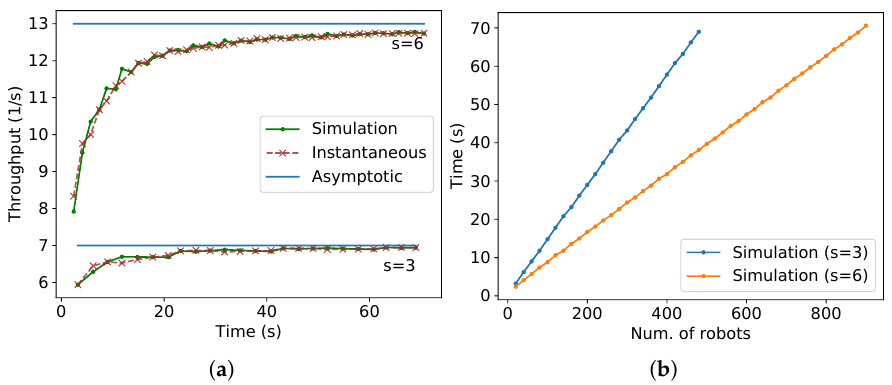
Figure 25. Plots for the experiments of parallel lanes strategy for s ∈ { 3,6 } m. ( a ) Number of robots versus throughput. ( b ) Number of robots versus the time of arrival of the last